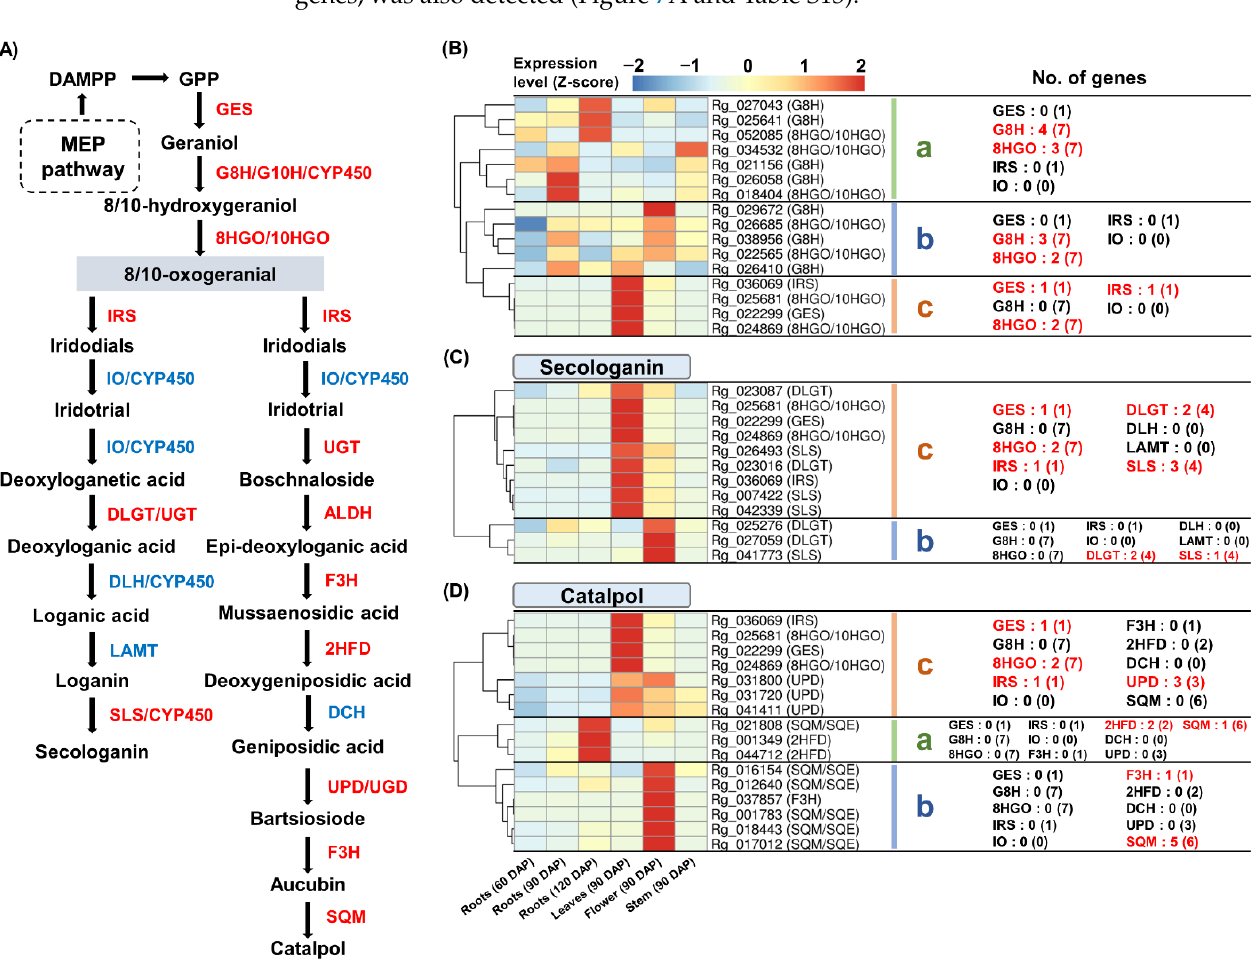
Figure 7. Expression analysis of two iridoids biosynthesis genes. ( A ) Secologanin and catalpol biosynthetic pathway in plants. Genes that were missing in this study and genes with <5 TPM values are shown in blue. ( B – D ) Heatmap analysis of genes involved in two iridoid pathways. ( a ) Genes cluster showing a high expression in the roots. ( b ) Genes cluster showing a strong expression in the 90 DAP flowers. ( c ) Genes cluster showing a strong expression in the 90 DAP leaves. Genes highlighted in red indicate genes assigned to each cluster and the number in parentheses is the total number of genes encoding the enzyme expressed in R. glutinosa transcriptome. TPM , transcripts per million.